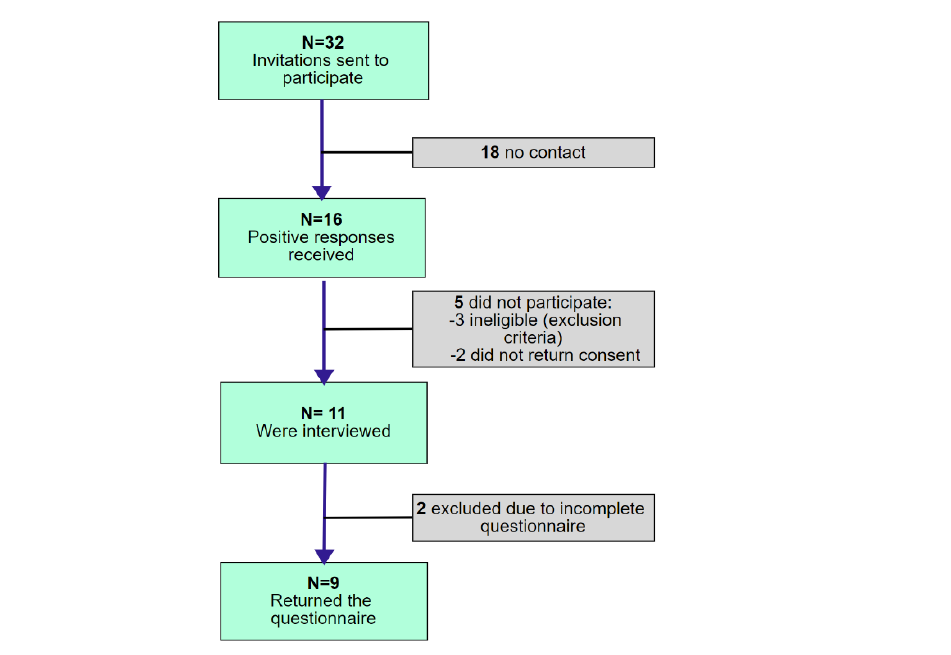
Figure 1. The flowchart of participant enrollment. Table 1. Sociodemographic data of study participants.